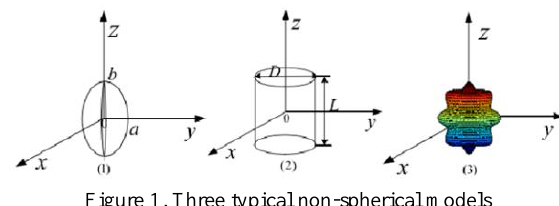
Figure 1. Three typical non-spherical